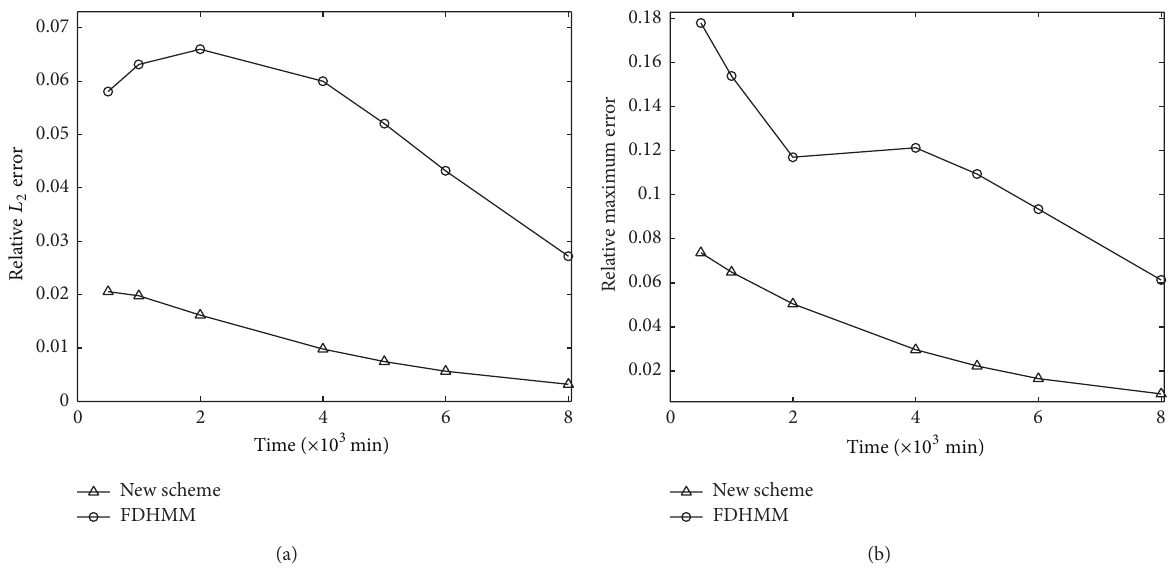
Figure 9: Relative (a) 𝐿 2 and (b) maximum errors between exact and two coarse solutions for aquifer response to sudden change in reservoir